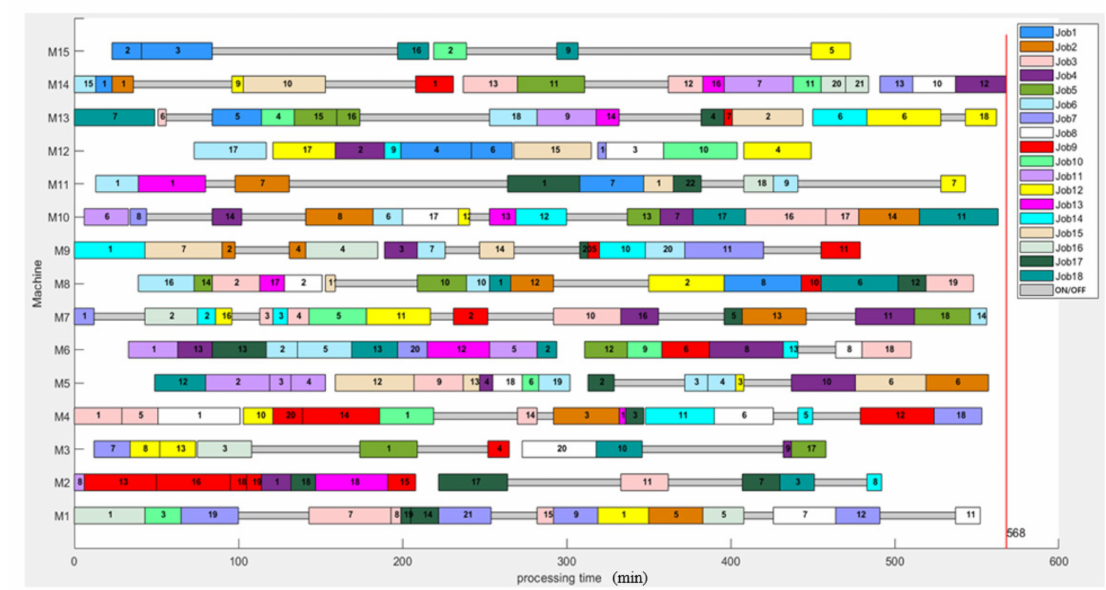
Figure 15. The Gantt chart of scheduling scheme for multi-objective optimization.